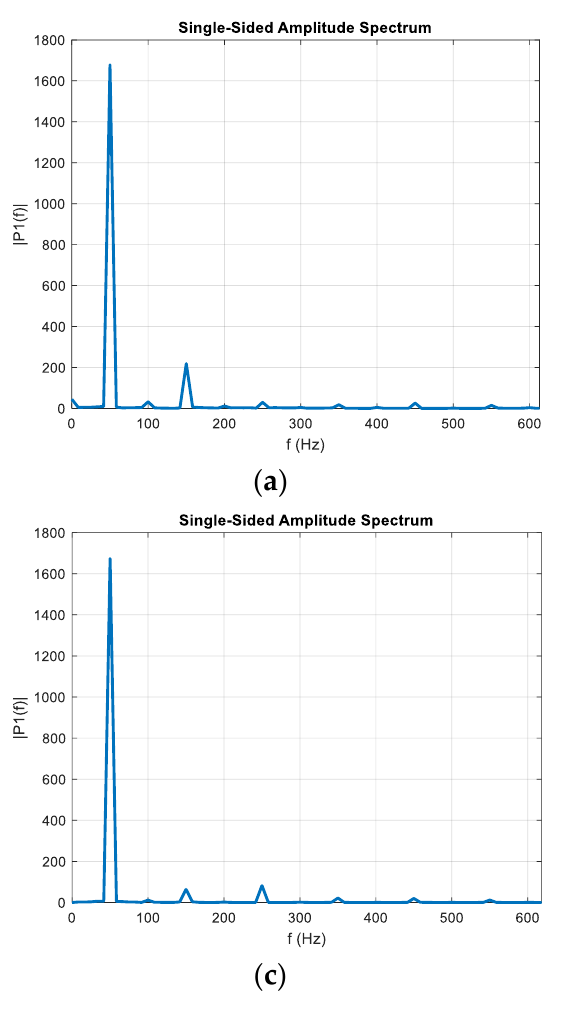
Figure 16. Harmonic distortion in the currents control of MTVR at the beginning of the perturbation (maximum control action): ( a ) — phase max angle A, max angle 35° (THDA = − 1.7 %); ( b ) — phase B, max angle 20° (THDB = 1.22 %); ( c ) — phase C, max angle 5° (THDC = 0.55 %).